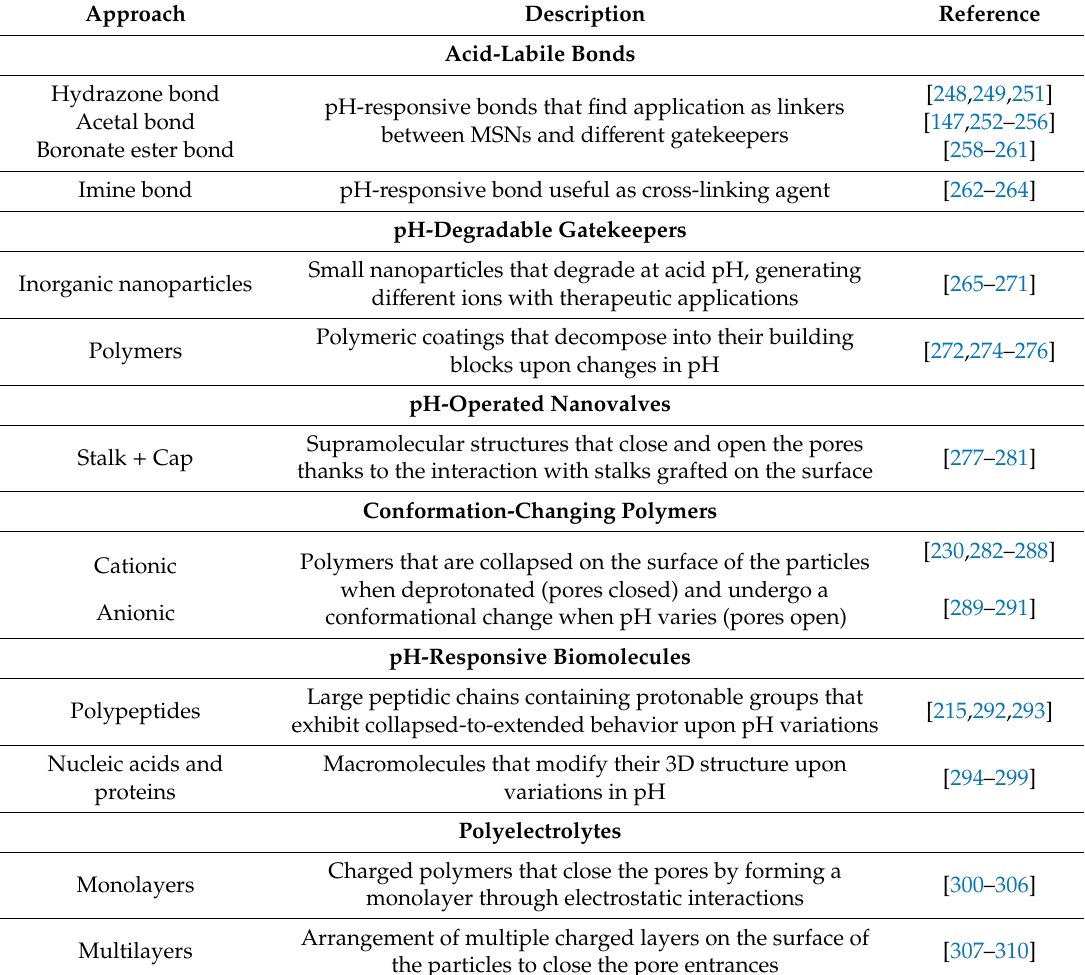
Table 3. Di ff erent strategies implemented into MSNs for achieving pH-responsive drug